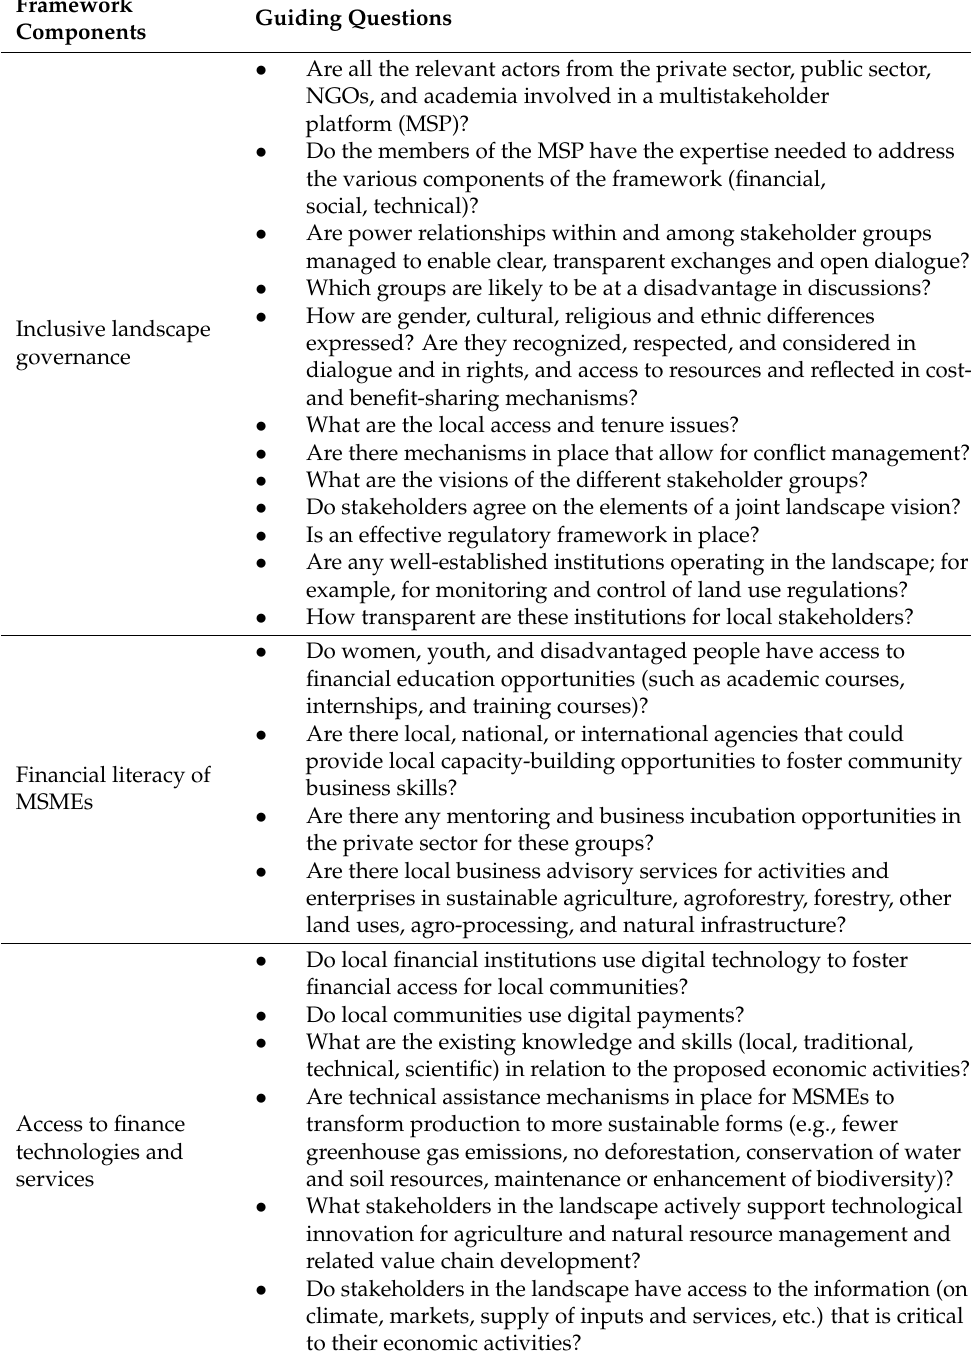
Table 2. Questions to assess the inclusiveness of landscape